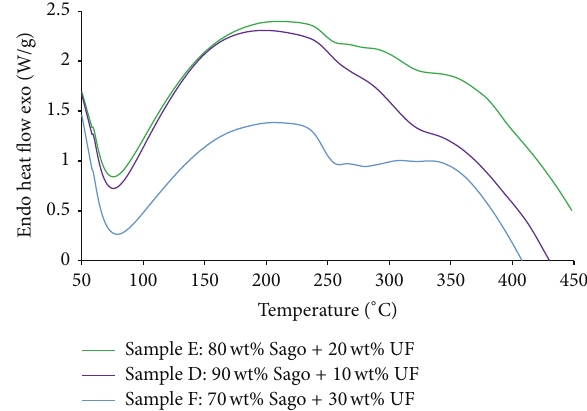
Figure 10: Sago/UF Sample with different weight fraction analysis by